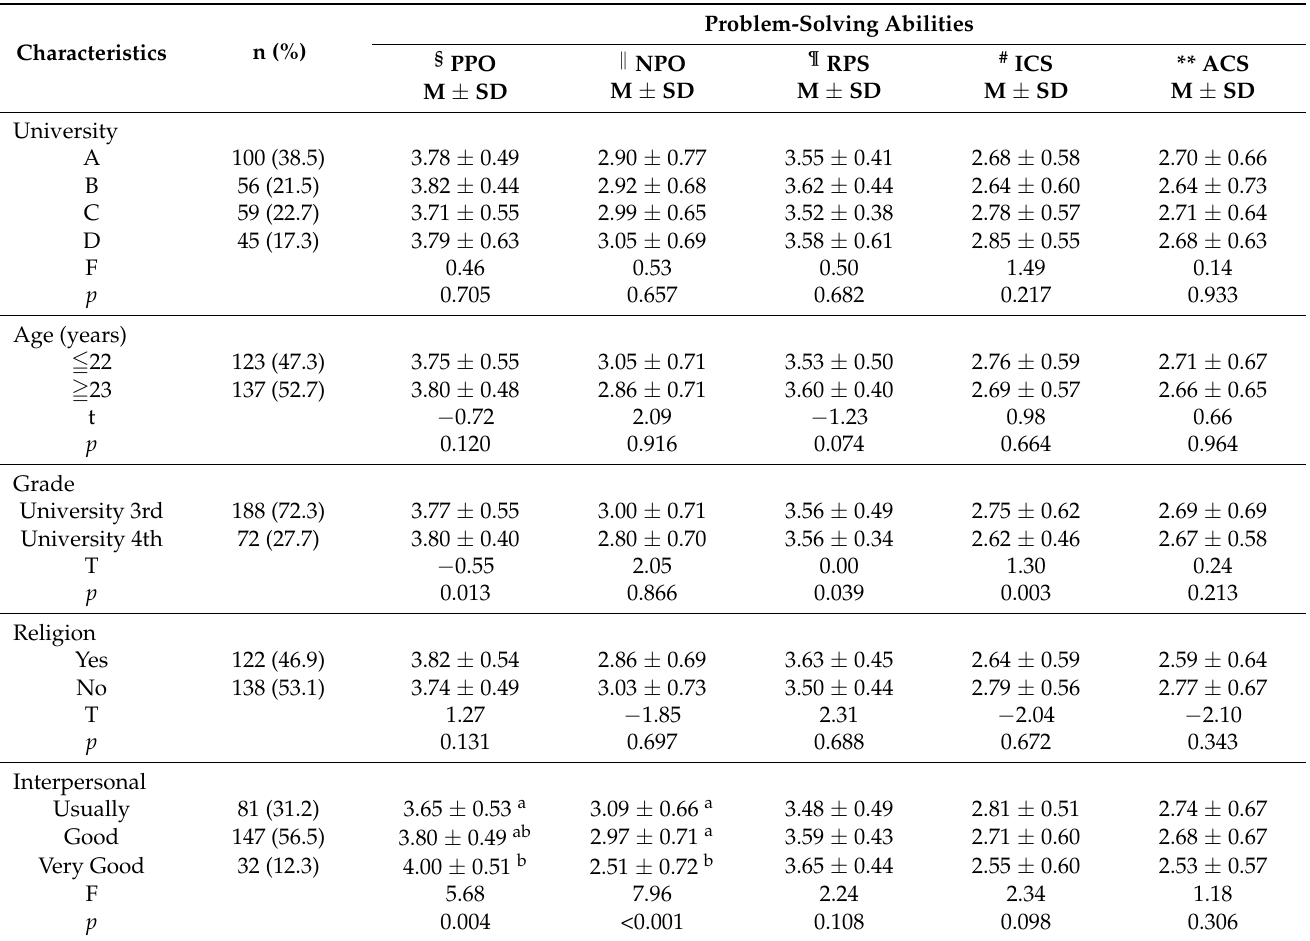
Table 2. General Characteristics of Subjects’ Problem-solving Abilities (N =